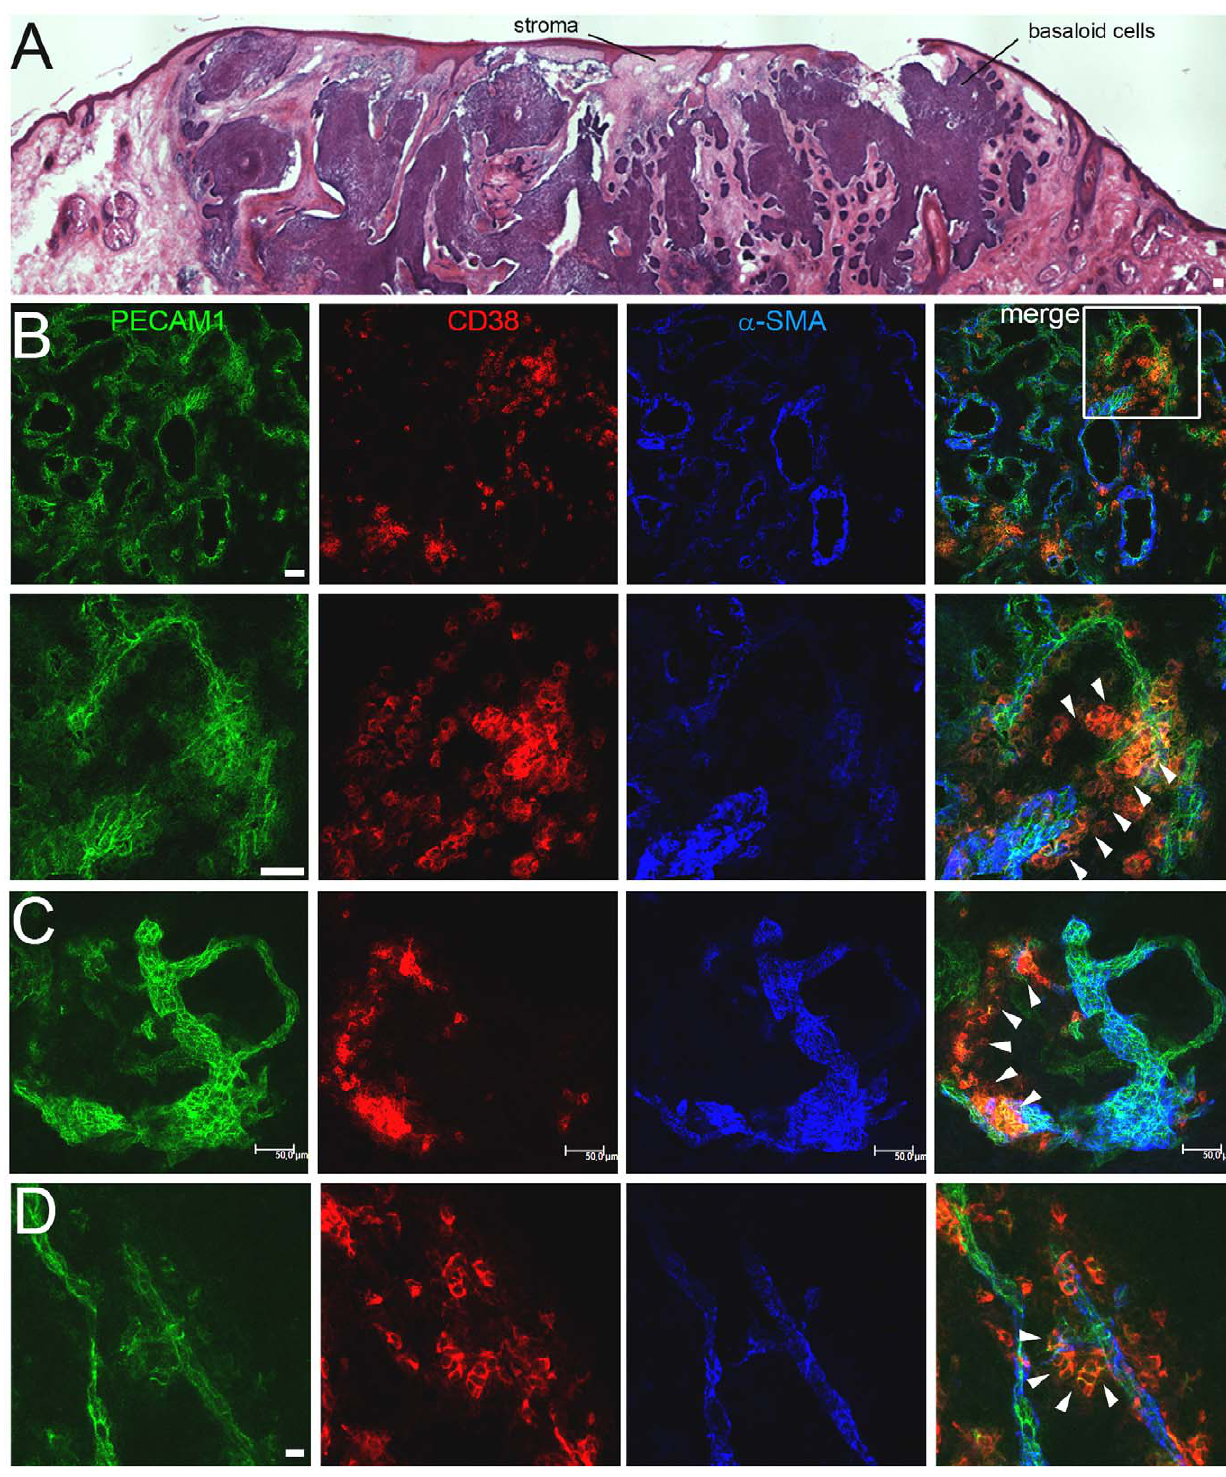
Figure 7. Identification of PECAM1 + /CD38 + cells in human basal cell carcinomas (BCC). (A) H&E-stained cryosection of a BCC. (B–D) Confocal microscopy analysis of PECAM1, CD38 and a -SMA expression in two BCC biopsies (B–C, D). (B) Overview (top row) of the highly vascularized PECAM1 + stroma. Squares within the merged image indicate the magnified region (lower row). PECAM1 low /CD38 + cells are marked (arrowheads). Bars 100 m m (A), 50 m m (B, C), 10 m m (D).